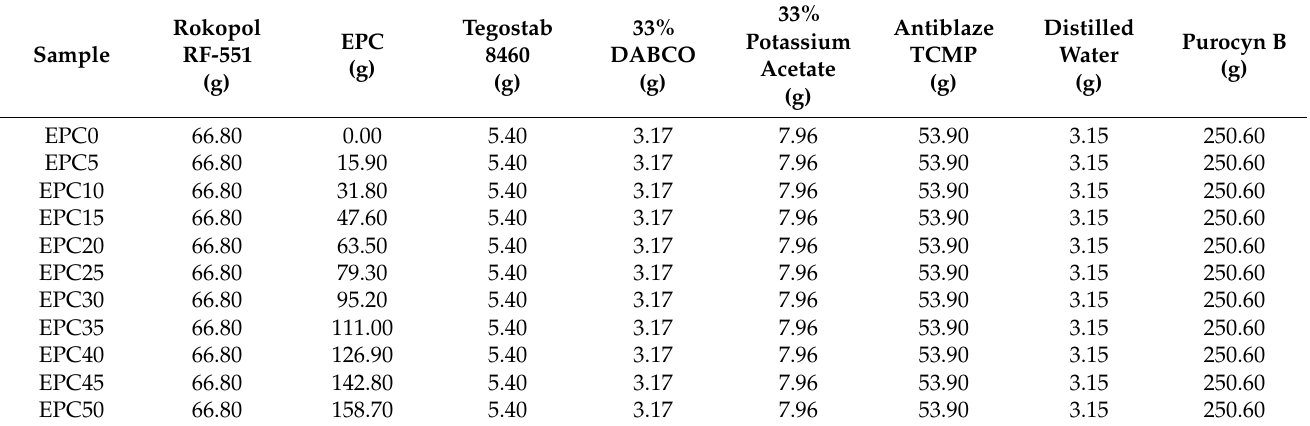
Table 8. Formulation of RPU/PIR foams modified by evening primrose oil